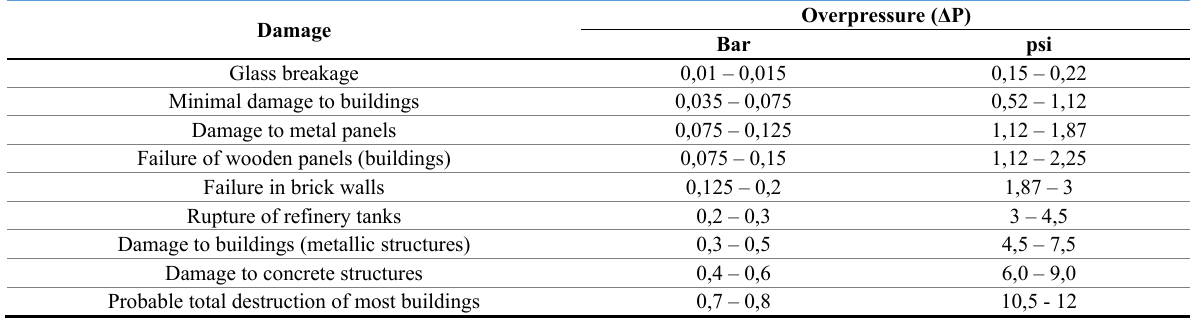
Table 2. Shock wave effects on structures [34].